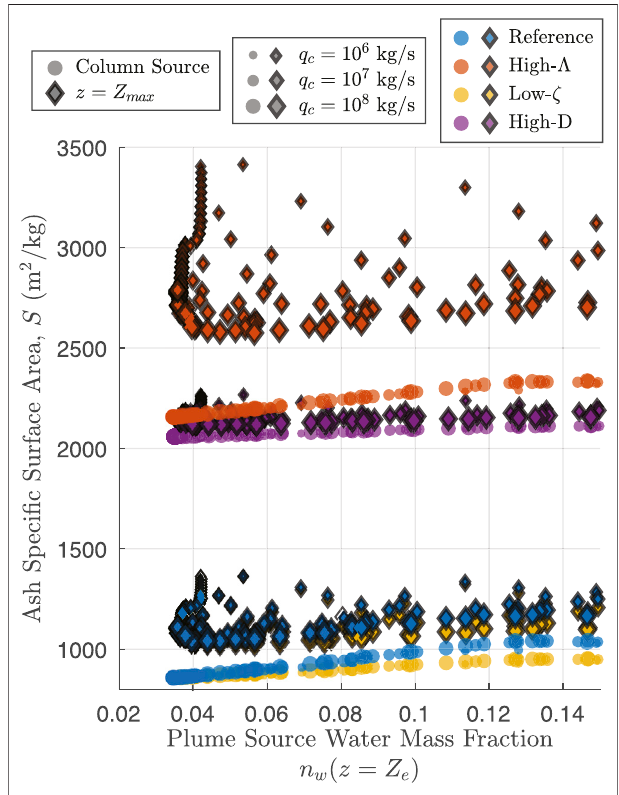
FIGURE 12| Pyroclastspeci fi c surface area as afunction of water mass fraction at the water surface (circles) and height of neutral buoyancy (diamonds) for scenarios with different fragmentation properties. The Reference scenarioisshowninblue.Reducingthefragmentationenergy ef fi ciency to ζ = 0.05 ( Low- ζ scenario, yellow symbols) reduces the amount of energy consumed to generate surface area per unit mass of entrained water, resulting in a smaller increase in S during MWI relative to the Reference scenario. Conversely, a high initial value of the PSD power-law exponent, D = 3.2 ( High-D scenario, purple symbols), concentratesinitial particlemass in the fi ne fraction. Because of the fi xed particle sizes for output from quench fragmentation used here (see Figure 3 ), there is relatively little particle mass available to fragment for the creation of new surface area and the relative change in S with water entrainment is small. Finally, increasing the particle roughnessscale, Λ =25( High- Λ scenario,red symbols), results ininitiallyhigh particle surface area, but also a greater energy requirement to generate new particles of a given size. This scenario results in the highest absolute changes in particle surface area after quench fragmentation and sedimentation, but a smaller relative change than for the Reference scenario.